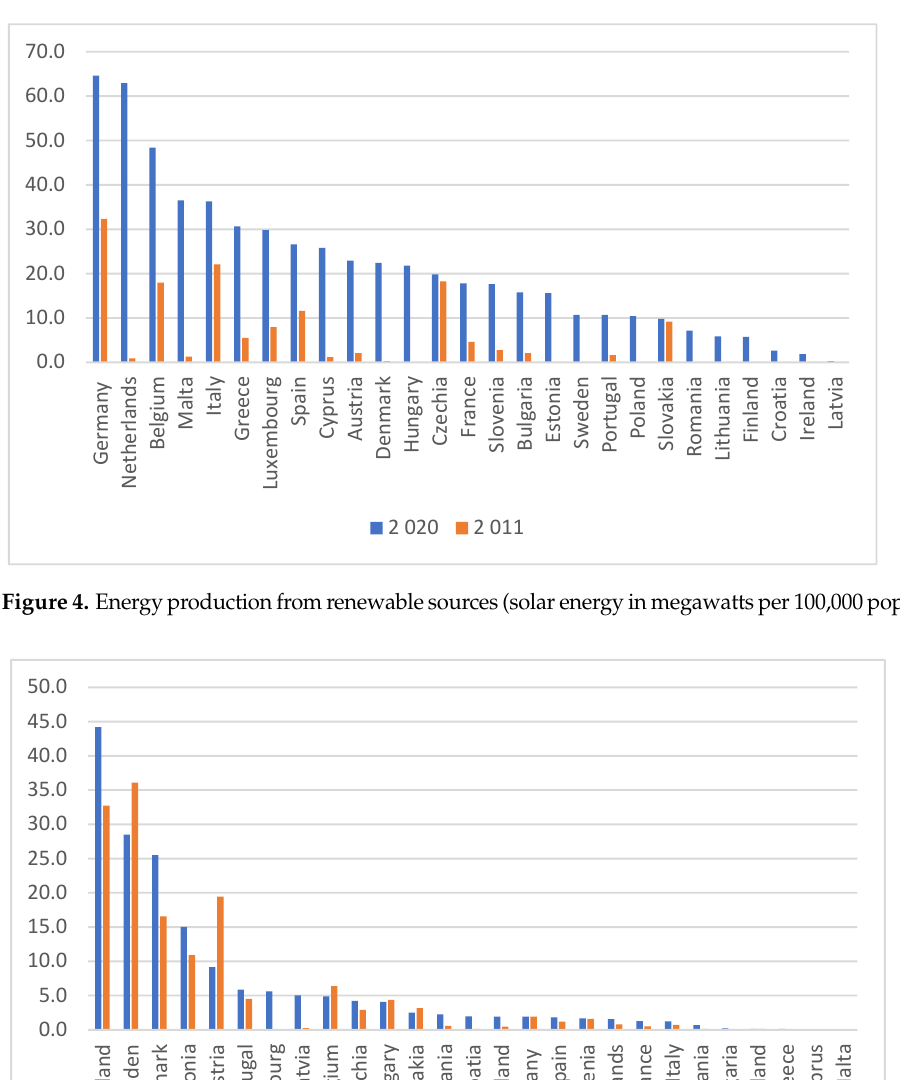
Figure 5. Energy production from renewable sources (solid biofuels energy in megawatts per 100.000 population).